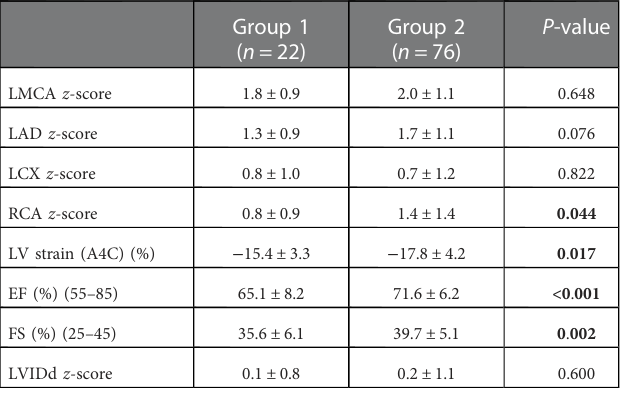
TABLE 2 Results of echocardiographic